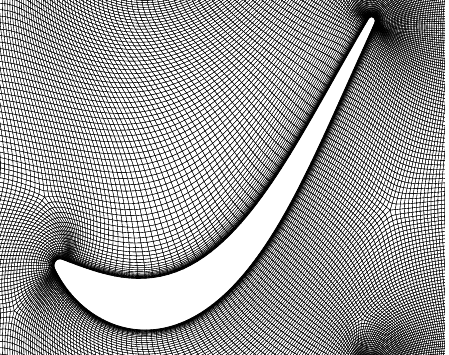
Figure 2. Grid topology discretizing the measured LPT stator